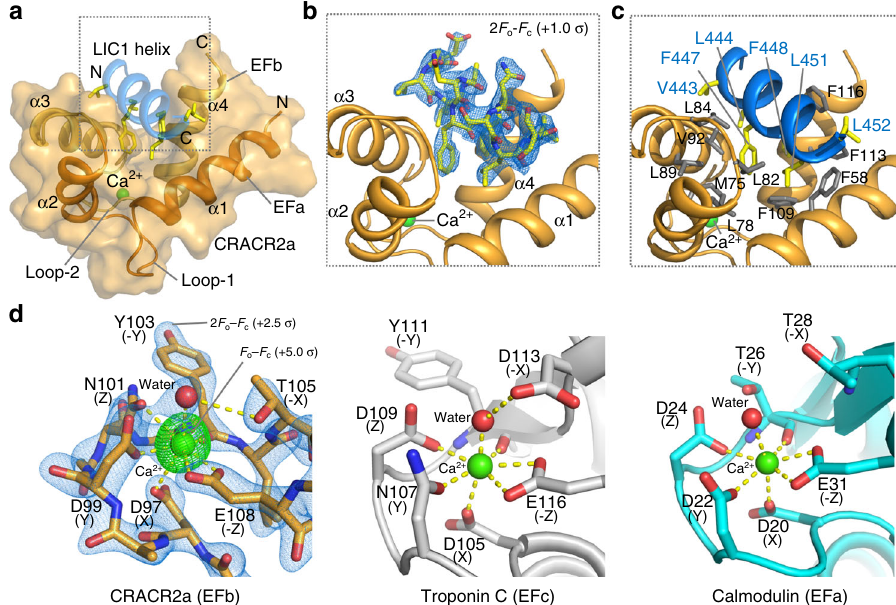
Fig. 4 Crystal structure of the EF-hand pair of CRACR2a in complex with LIC1 433 – 458 . a Ribbon diagram and surface representation of the structure of the complex of human CRACR2a 47 – 122 (the fi rst and second EF-hands are colored dark and light orange, respectively) with LIC1 433 – 458 (blue). The side chains of LIC1 433 – 458 are shown using a stick representation and colored by atom type. b , c Close-up views showing the binding of LIC1 433 – 458 in a hydrophobic cleft formed between the incoming ( α 1 and α 3) and exiting ( α 2 and α 4) helices of the two EF-hands. The 2Fo – Fc electron density map (blue mesh) contoured at 1.0 σ is shown around an all-atom representation of the LIC1 helix. Note that residues on the hydrophobic face of the LIC1 helix insert into the hydrophobic cleft formed by the EF-hand pair (side chains colored gray). d Close-up view of the Ca 2 + -binding loop (located within the second EF-hand) of human CRACR2a (left) compared to the third Ca 2 + -binding loop of human troponin C (middle, PDB code: 1J1D) and the fi rst Ca 2 + -binding loop of human calmodulin (right, PDB code: 1CLL). The 2Fo – Fc electron density map (blue mesh) contoured at 2.5 σ is shown around the atoms of CRACR2a and a Fo – Fc difference map (green mesh) contoured at 5.0 σ is shown around the bound Ca 2 +